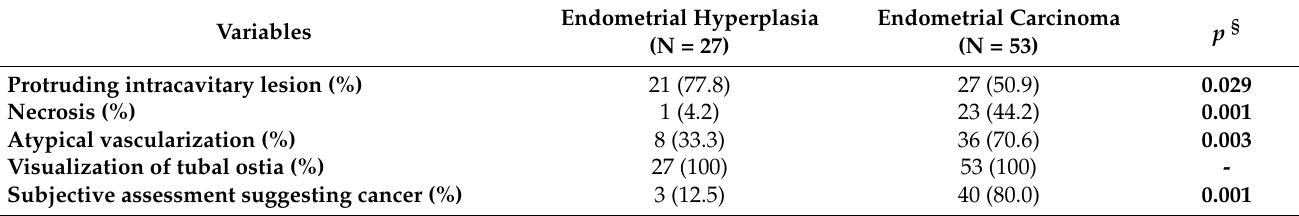
Table 4. Hysteroscopic findings in the two groups.